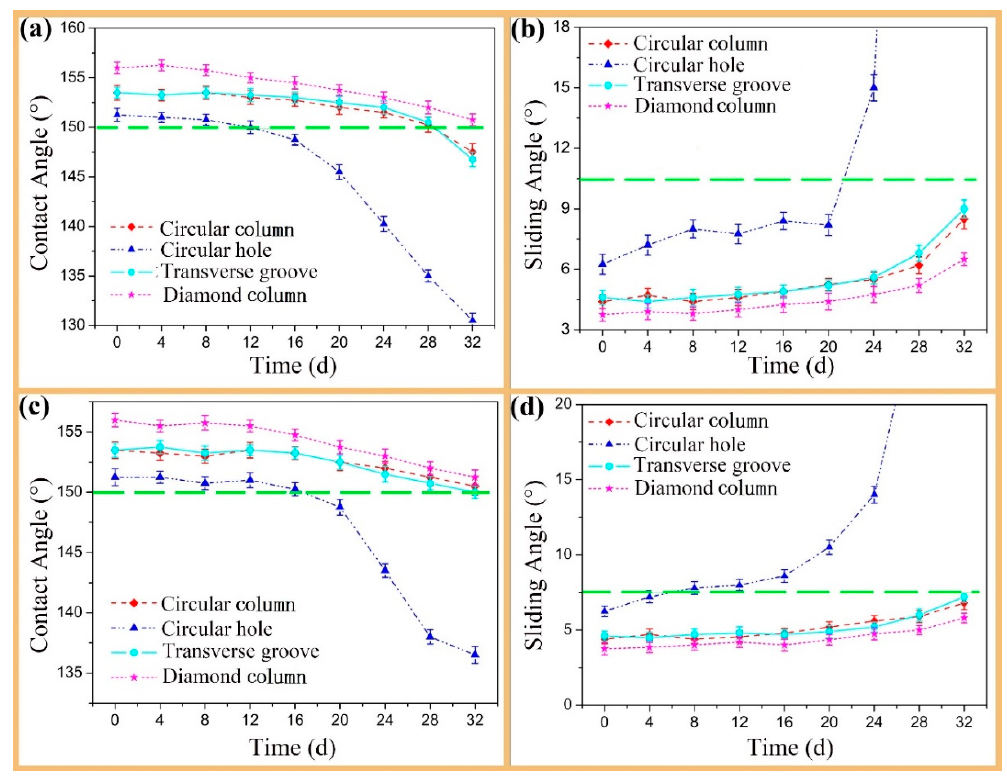
Figure 6. Curves of the CA ( a , c ) and the SA ( b , d ) of the droplet on different texture designs over time when soaked in ( a , b ) 1 mol/L HCl ( c , d ) 1mol/L NaOH.